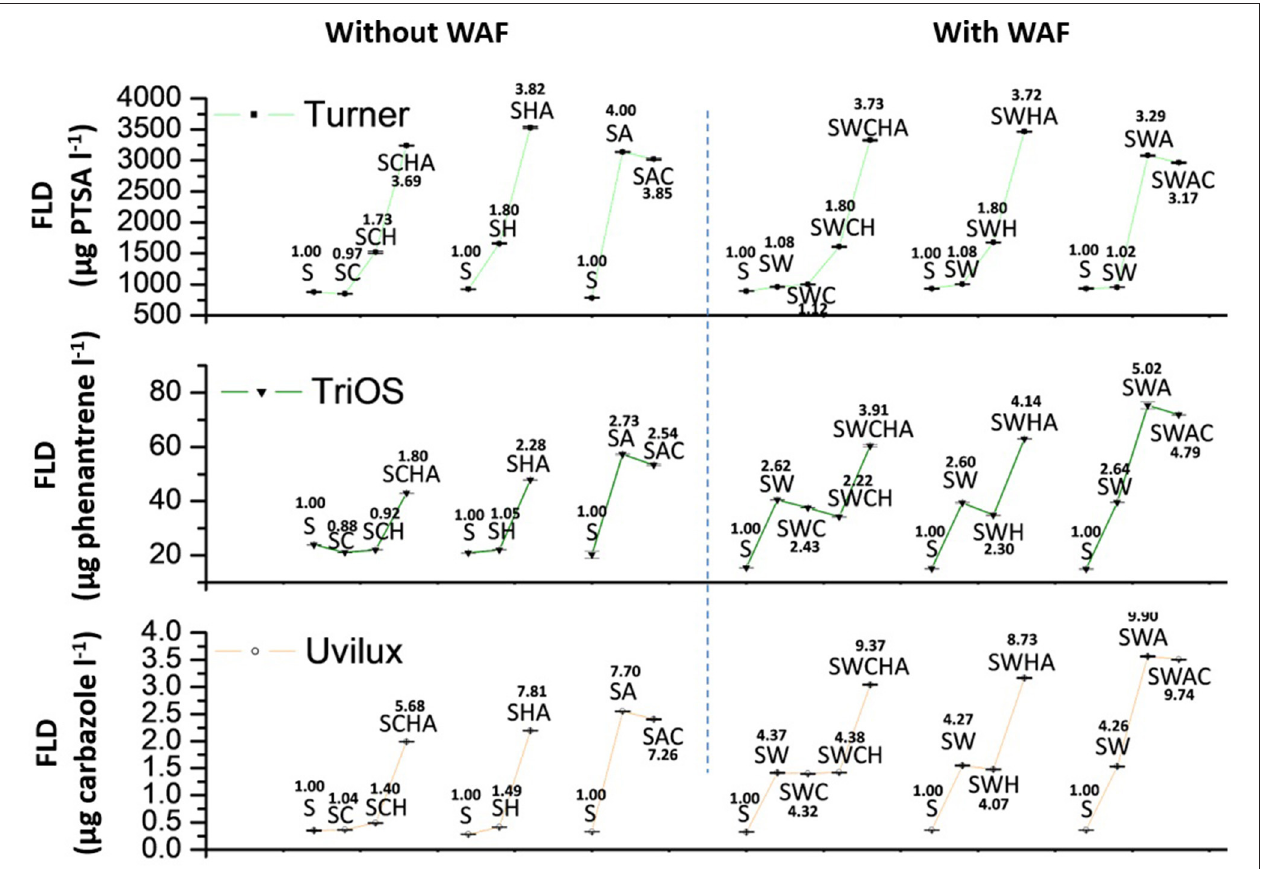
FIGURE 6 | Fluorescence responses from EnviroFlu-HC (TriOS), Turner C3 (Turner) and UviLux sensors in seawater, seawater containing interferences of clay, humic substances, algae substances, and seawater containing diesel WAF with and without the interferences. S = seawater, C = clay suspension, H = humic substance extract, A = cyanobacterial algae extract, and W = water accommodated fraction (diesel fuel extracted in seawater). PTSA = 1,3,6,8-pyrenetetrasulphonic acid tetrasodium salt. The change in FLD response respective to the baseline (S) value in each series (e.g., S–SC–SCH–SCHA) is indicated on top of each